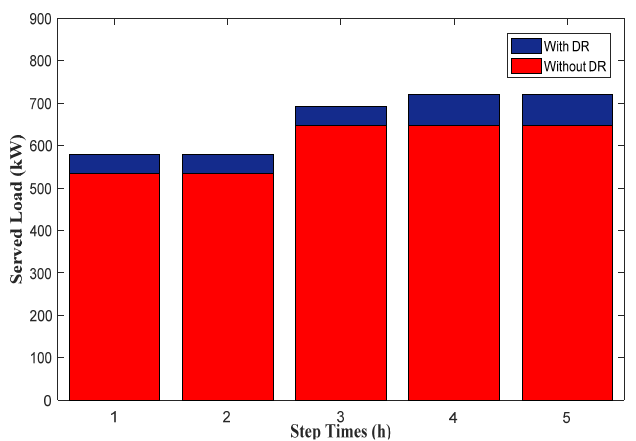
Figure 8. The effect of EDRP on the served load in the 34 bus case. Figure 8. The e ff ect of EDRP on the served load in the 34 bus case.